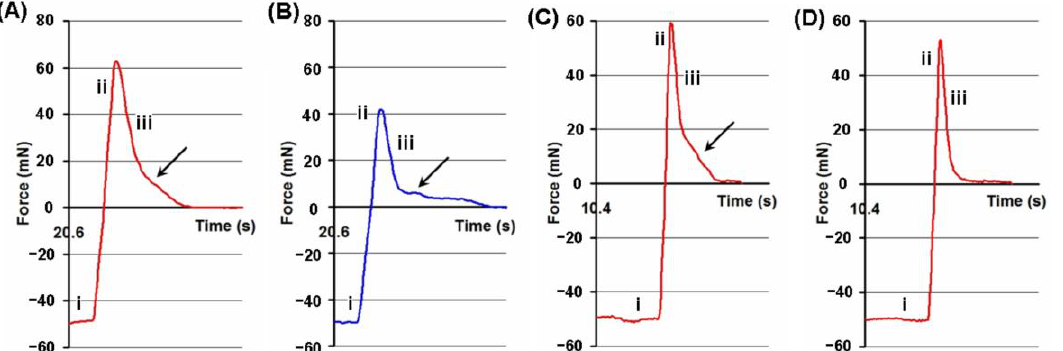
Figure 2. Tensile strength adhesive curve of the interaction of the pectin hydrogels with the serosa. Adhesion of FeP ( A, red line) and CaP ( B, blue line) hydrogels at a single attachment-detachment event with a compression force of 50 mN and a compression time of 20 s. Adhesion of FeP hydrogel at the first ( C ) and fifth ( D ) cycles of attachment-detachment with a compression force of 50 mN and a compression time of 10 s. Arrows show the protracted segment of the debonding curve. The following phases of the adhesion test are shown: the compression phase (i), the deadhesion phase (ii), and the debonding phase (iii).